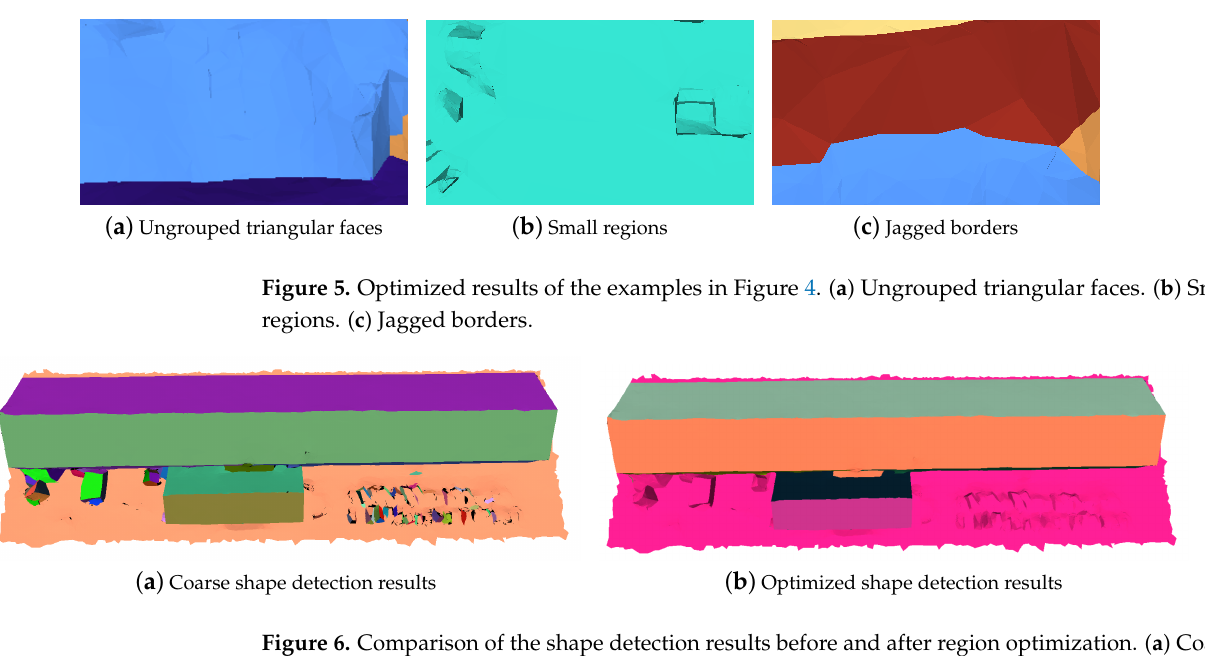
Figure 6. Comparison of the shape detection results before and after region optimization. ( a ) Coarse shape detection results. ( b ) Optimized shape detection